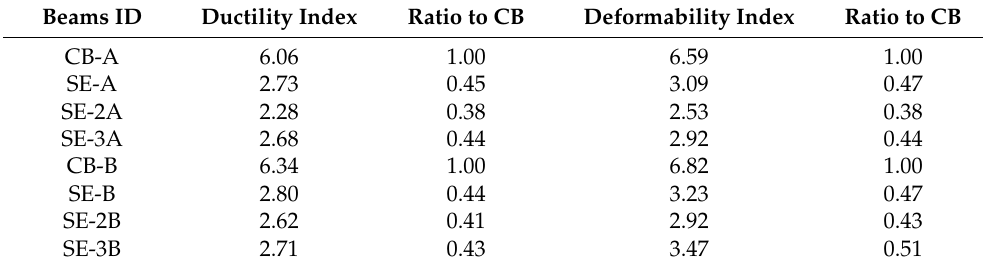
Table 4. Summary of indices.